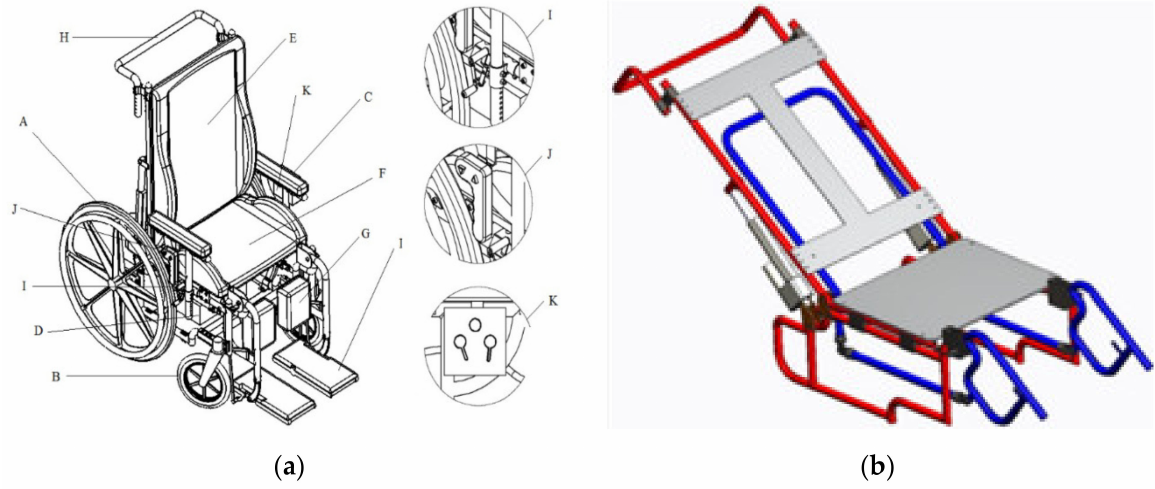
Figure 1. Wheelchair CAD model; ( a ) Wheelchair components, ( b ) Support and mechanism parts of the wheelchair